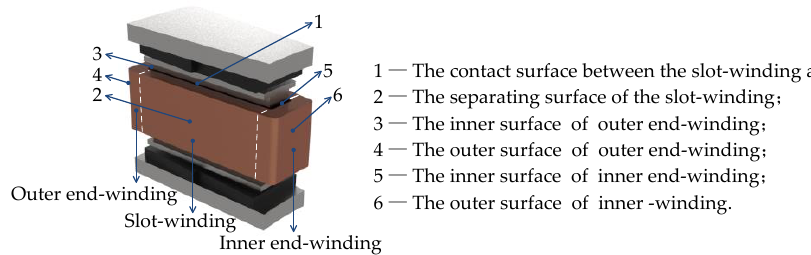
Figure 3. Position in the cross-section of the segmented stator.